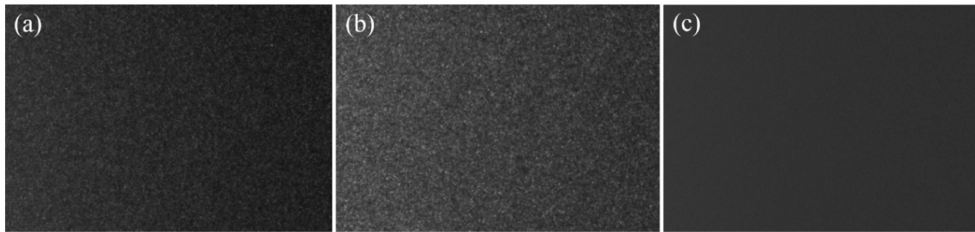
Figure 7. GOHYLED graininess images of ( a ) a pearlescent, ( b ) a metallic and ( c ) a solid sample for the − 15 ◦ x: 0 ◦ geometry when illuminated with the white LED cluster.